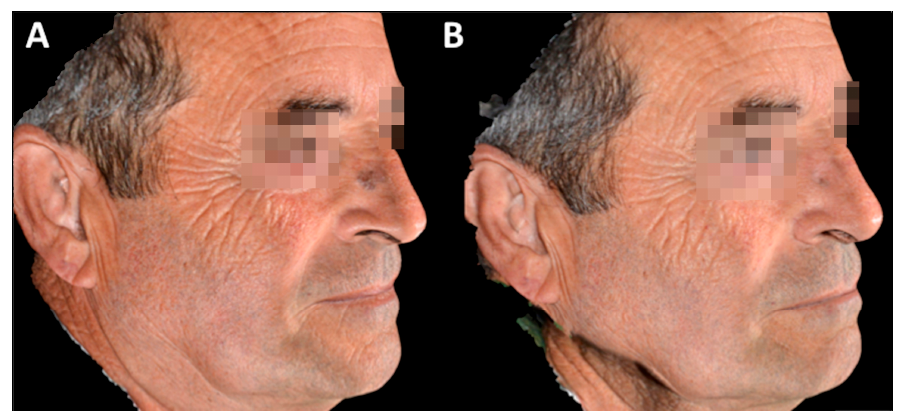
Figure 3. Three-dimensional (3D) images of partial clinical response: ( A ) before and ( B ) at 6 months following MAL-PDT using IPL as light source. Table 1. Complete clinical and dermoscopic clearance rates six months after last MAL-PDT using IPL as light source.